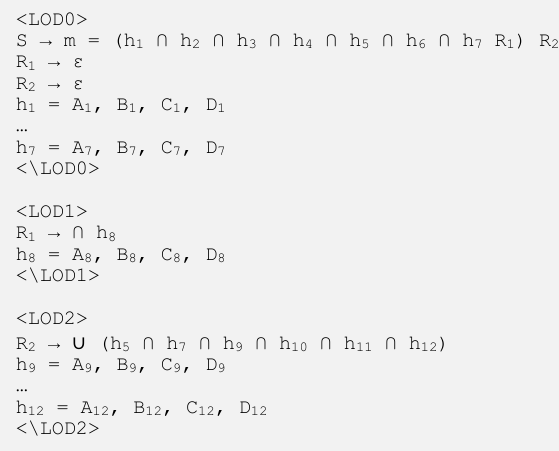
Figure 3. Three LODs of the example 3D building model in the proposed progressive transmission